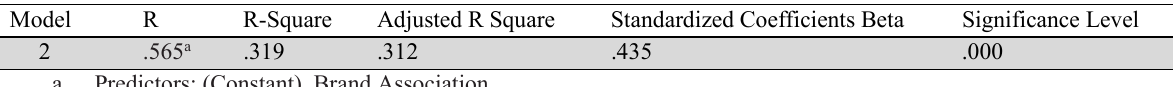
Model Summary for the second hypothesis